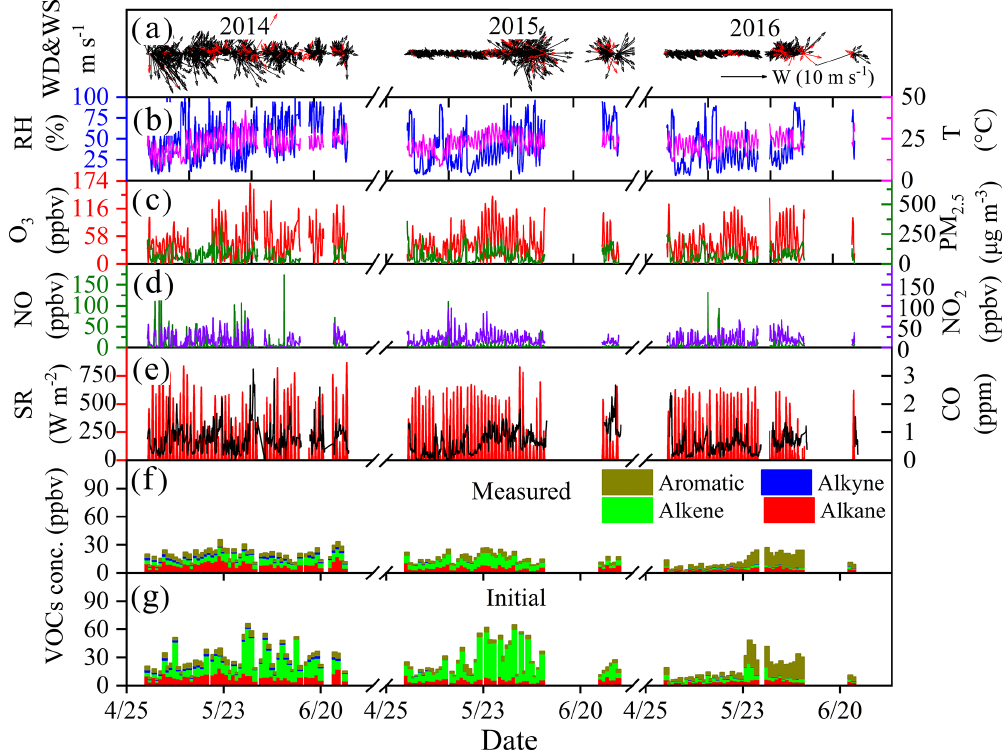
Figure 1. Time series of air pollutants and meteorological parameters during observations in Beijing. In panel a , the red arrows represent the O 3 concentration exceeding 74.6ppbv according to the national ambient air quality standard.